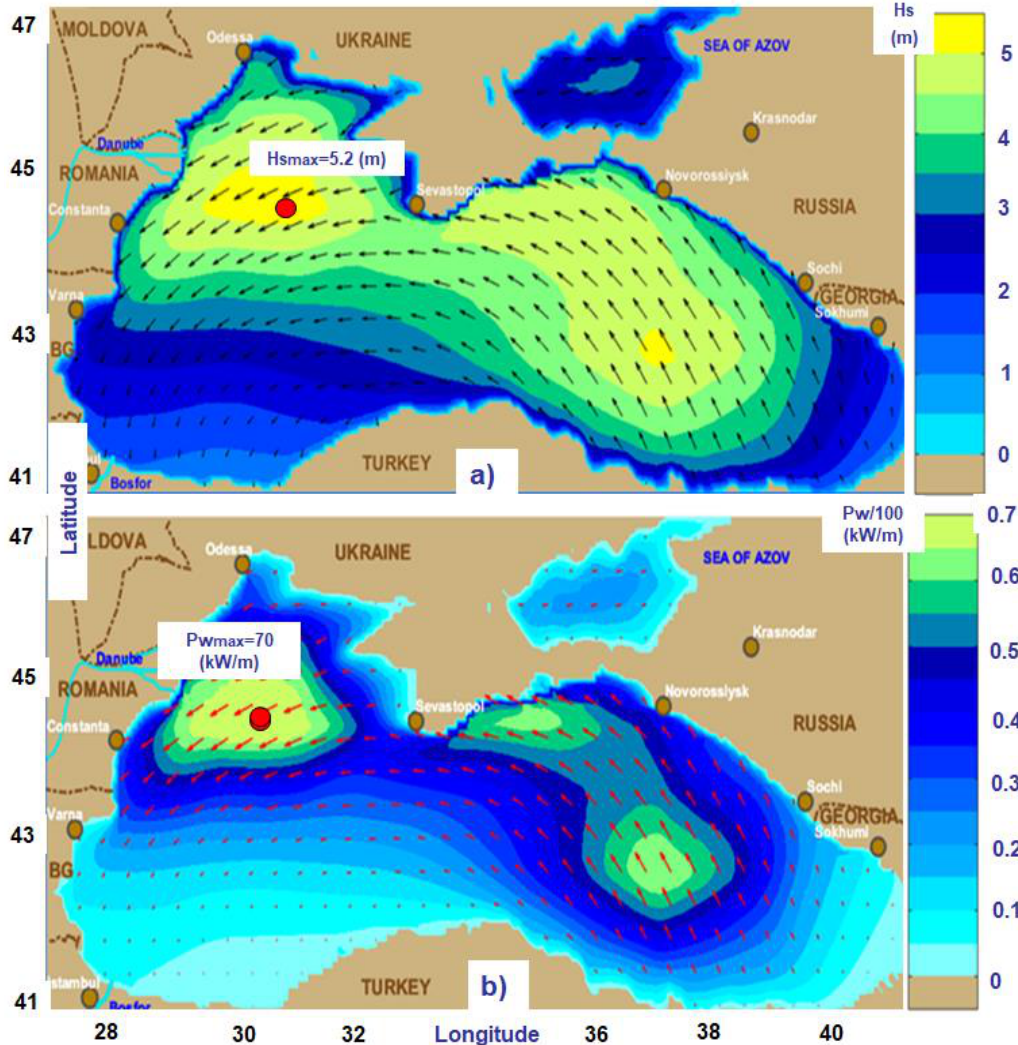
Figure 4. High wave conditions in the Black Sea (computational domain Sph1), model results corresponding to the time frame 8 January 2017. ( a ) Significant wave height scalar fields and wave vectors (represented by black arrows); ( b ) wave power scalar fields and energy transport vectors (represented by red arrows). The maximum values of the significant wave height and wave power are also indicated.